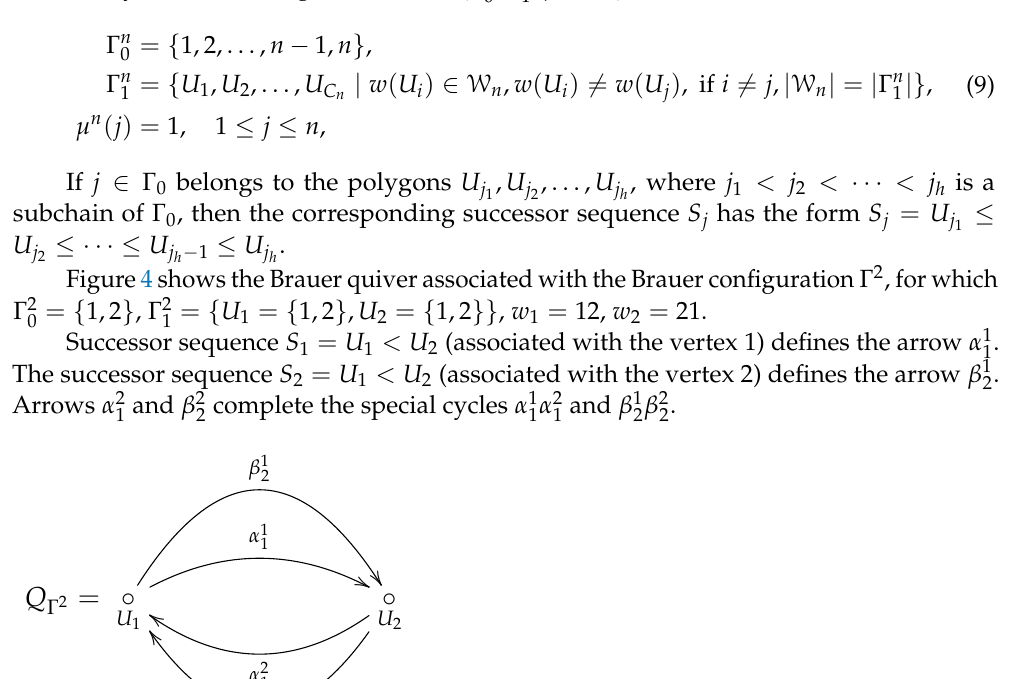
β 2 β 1 , α 2 , 2 2 1 1